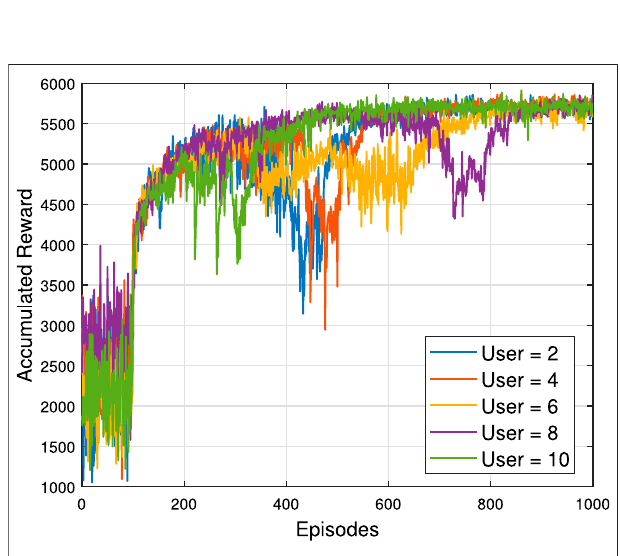
FIGURE 5 | Number of episodes versus accumulated reward for different numbers of users P t = 10dB, N =